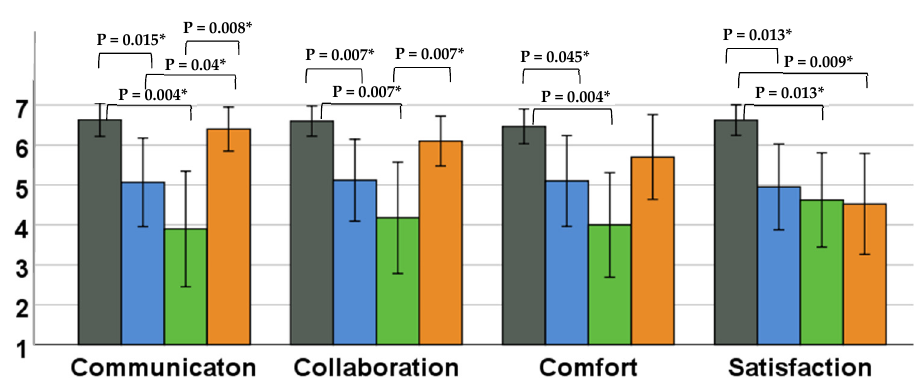
Figure 11. Mean ratings with significant results (*: statistically significant) on the communication, collaboration, comfort, and satisfaction categories depending on four position arrangements for the shared group. Error bar indicates 2 standard errors.